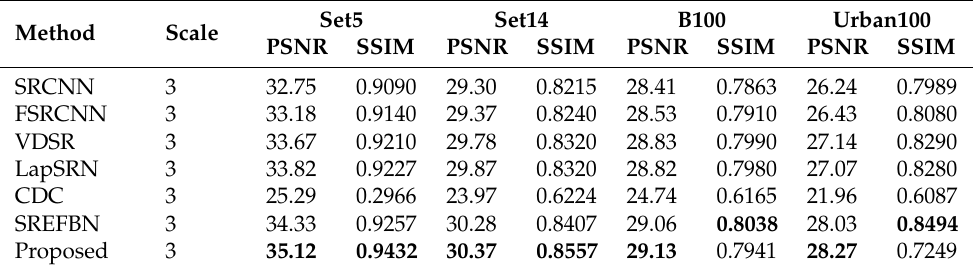
Table 2. Quantitative comparison of 3 × super-resolution results obtained by different methods.